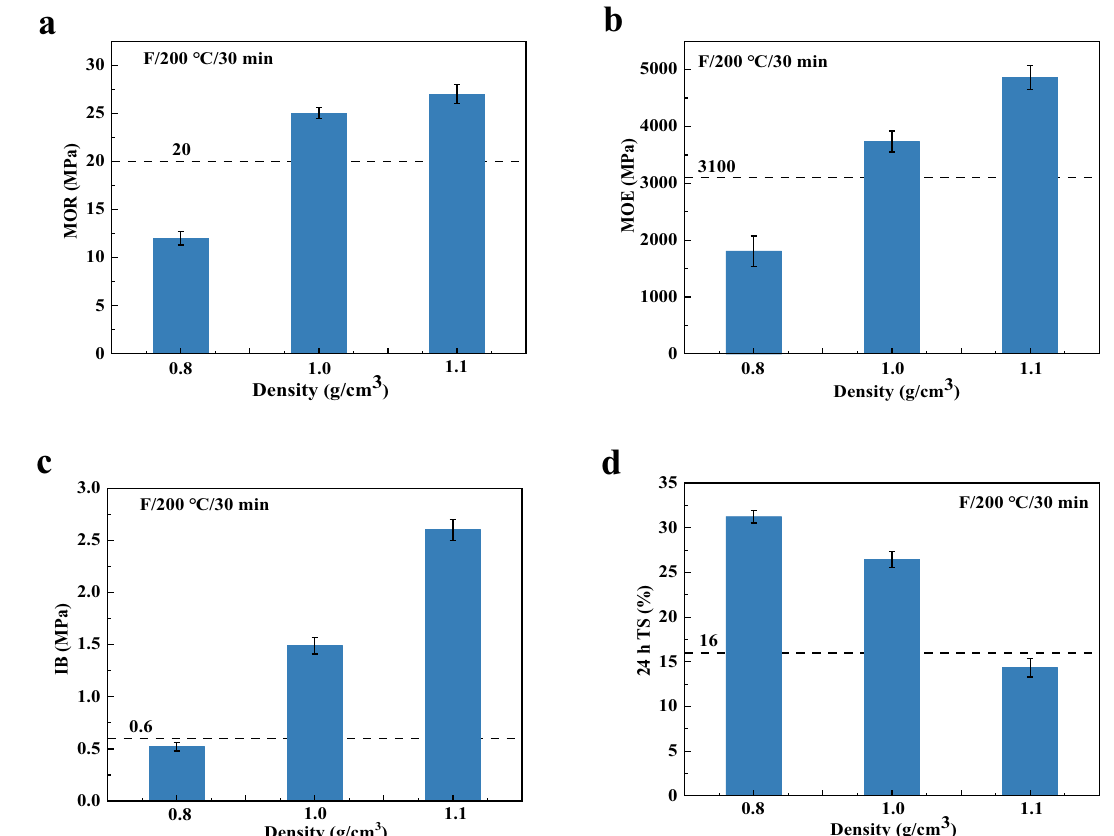
Fig. 5 Effects of board density on physical and mechanical properties of binderless boards. a Effects of board density on the MOR of binderless board. b Effects of board density on the MOE of binderless board. c Effects of board density on the IB of binderless board. d Effects of board density on the 24 h TS of binderless board. Error bars indicate standard